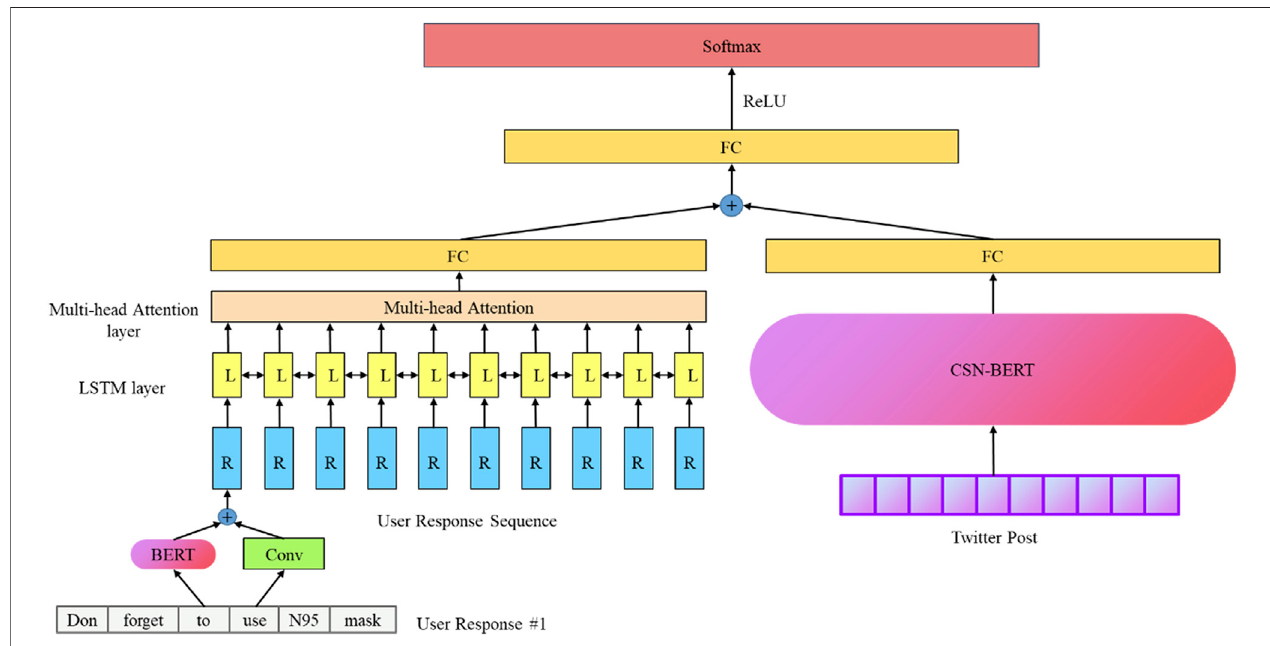
FIGURE 3 | The full view of